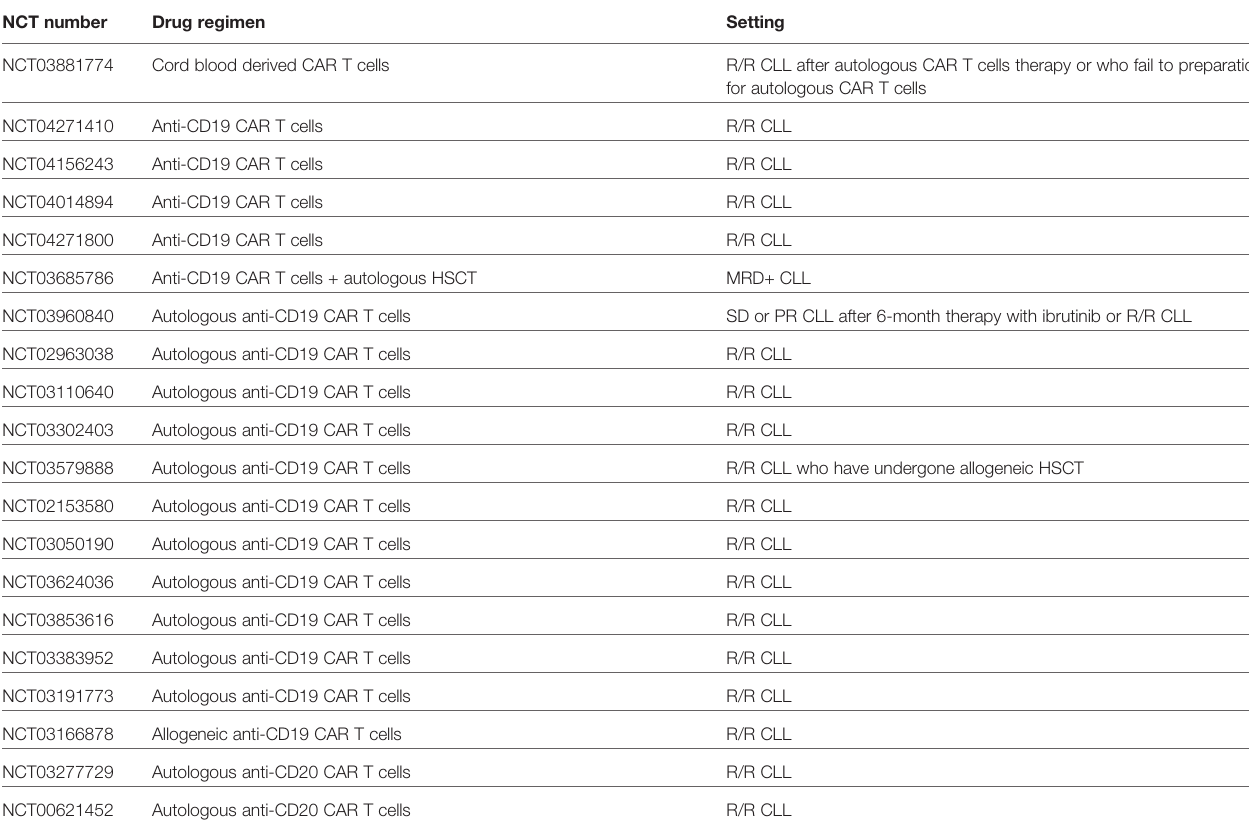
TABLE 3 | Ongoing clinical trials evaluating CAR T-cell treatment in CLL